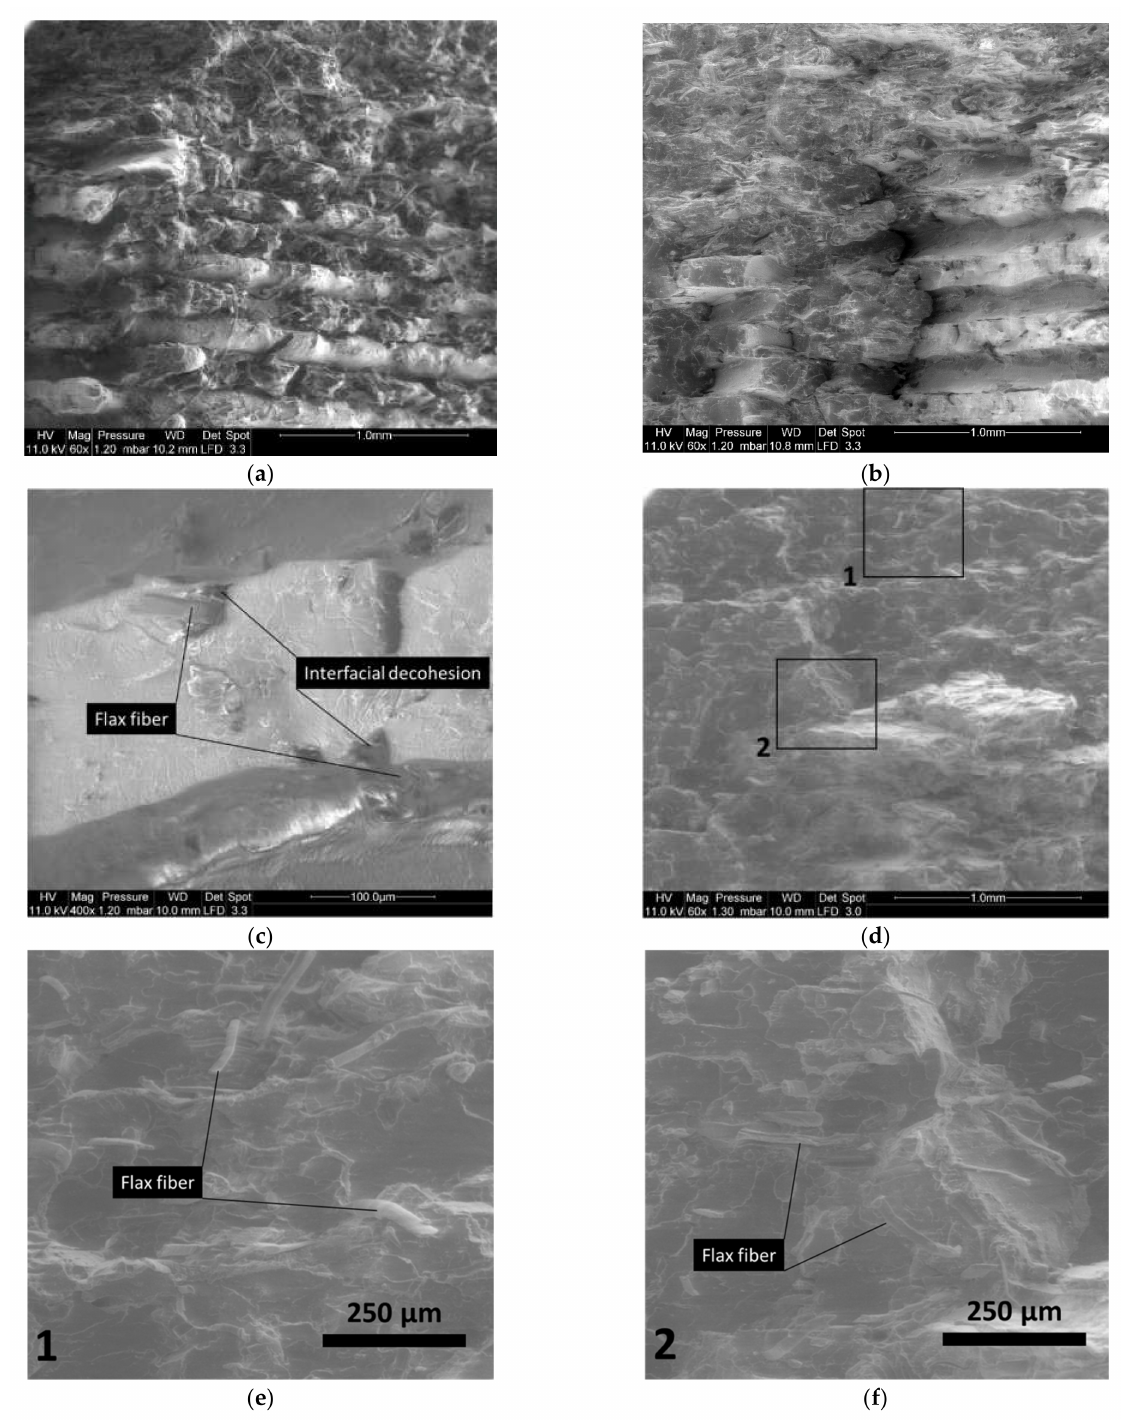
Figure 8. SEM micrographs showing the effect of bed temperature on the topography of PLA-flax fractured surfaces (T C = 200 ◦ C, Θ = 0 ◦ ): ( a ) T B = 50 ◦ C scale of several filament layup; ( b ) T B = 50 ◦ C a closer view of the filament layup; ( c ) T B = 50 ◦ C zoomed-view on filament cross-section; ( d ) T B = 60 ◦ C scale of filament layup with two framed areas; ( e ) T B = 60 ◦ C zoomed-view of the flax fibre structure within the raster; ( f ) T B = 60 ◦ C another location on the same micrograph showing flax